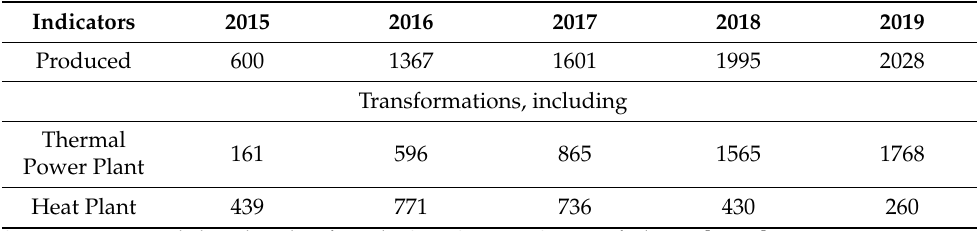
Table 3. Dynamics of production and conversion of biogas,